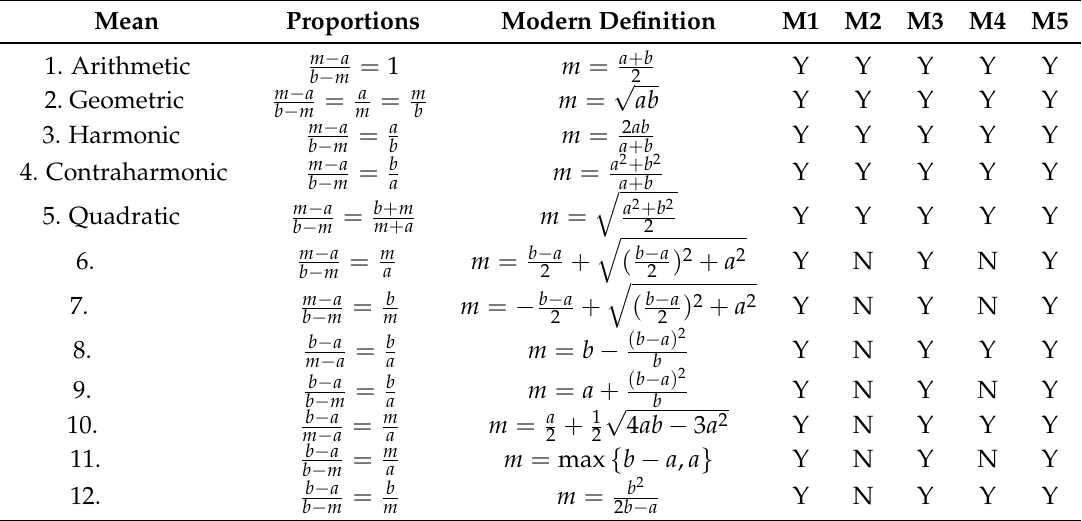
Table 1. The basic classic (Babylonian/Hellenistic) means defined by proportions between the variables and the